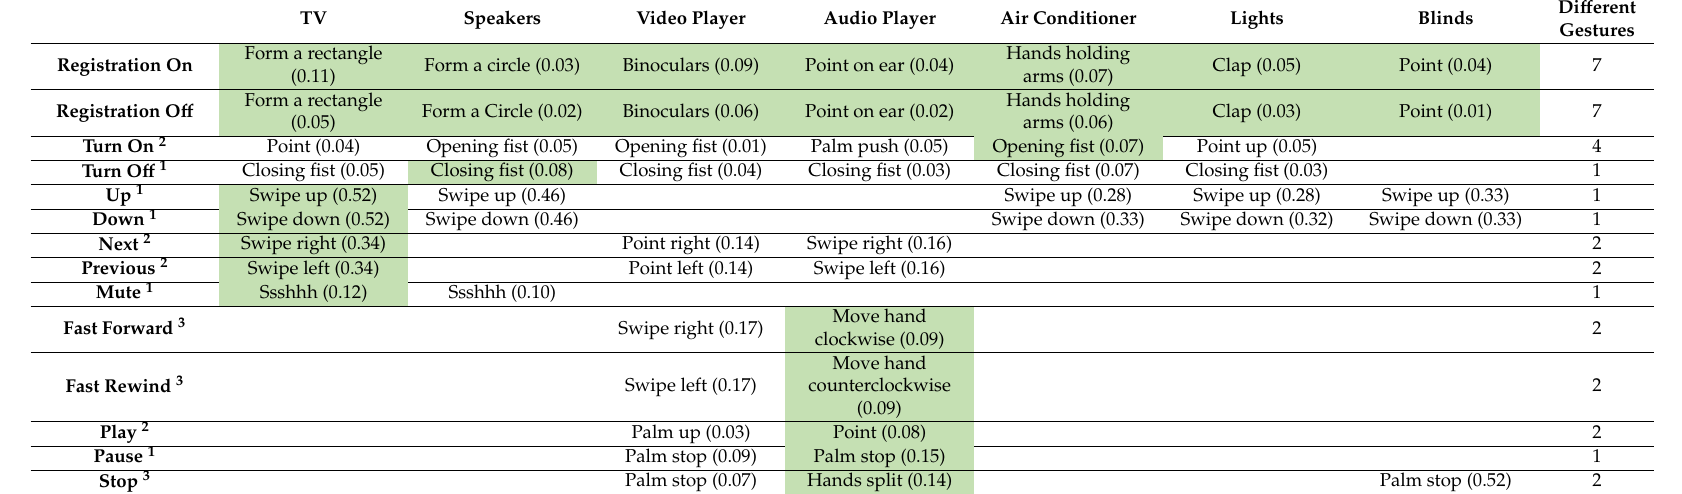
Table A1. List of gestures with the corresponding Agreement Rate (AR(r)) for each command which were proposed in the research of Vogiatzidakis and Koutsabasis [8]. We refer to this gesture set as GS el . The last column shows the number of di ff erent gestures for each command. If for a command more than one gesture is proposed, the one with the higher AR(r) is kept unless it is the only option on another command. All registration gestures are kept since they are